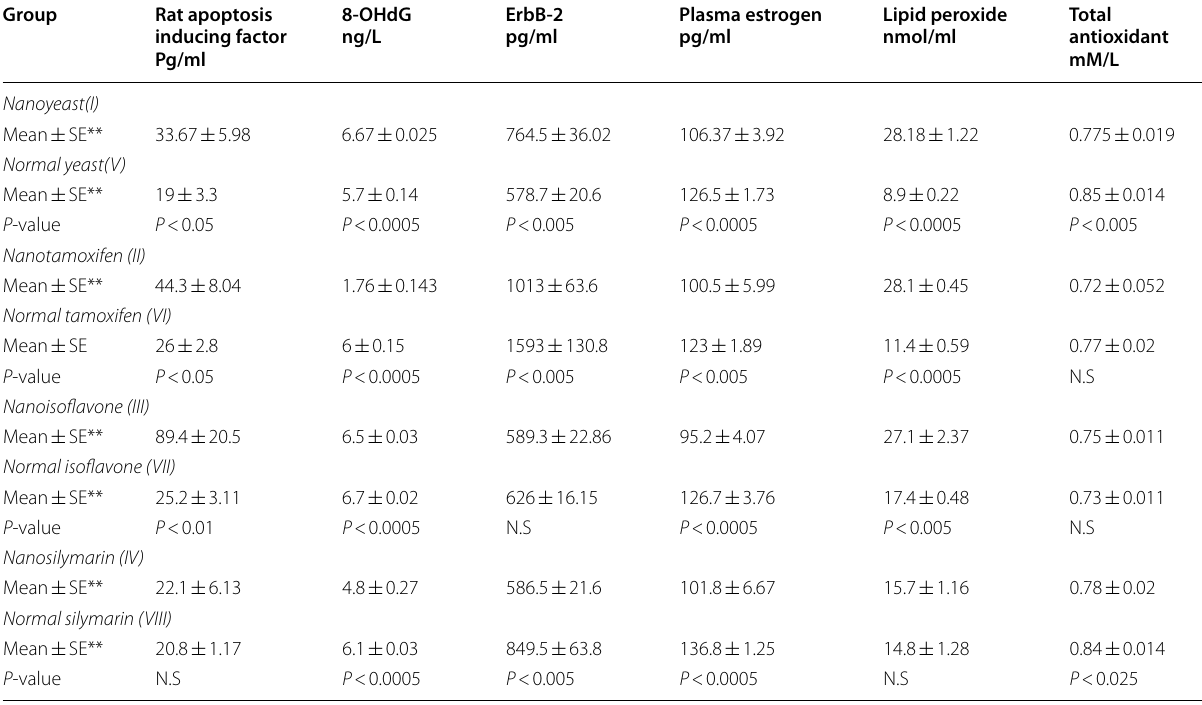
Table 2 Compared the influence of nano- and normal bioactive compounds on apoptosis, 8-OHdG, ErbB-2, plasma estrogen, lipid peroxide and total antioxidant (prevention